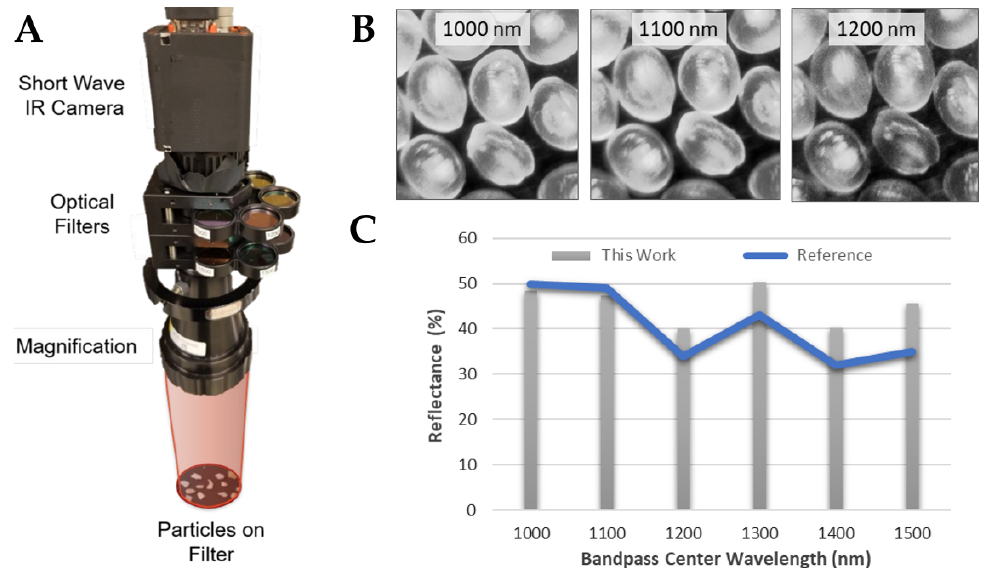
Figure 6. ( A ) Draper’s SWIR MP sensor setup. ( B ) Filtered images of the same field of PP MP at three bandpass wavelengths. Their individual reflectances are captured by the SWIR camera. ( C ) Comparison of the measured reflectance from a single particle at six bandpass wavelengths against the reflectance spectrum shown in Masoumi et al. (2012) [90], showing strong